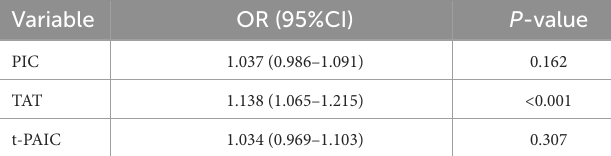
TABLE 2 Logistic regression analysis of risk factors for